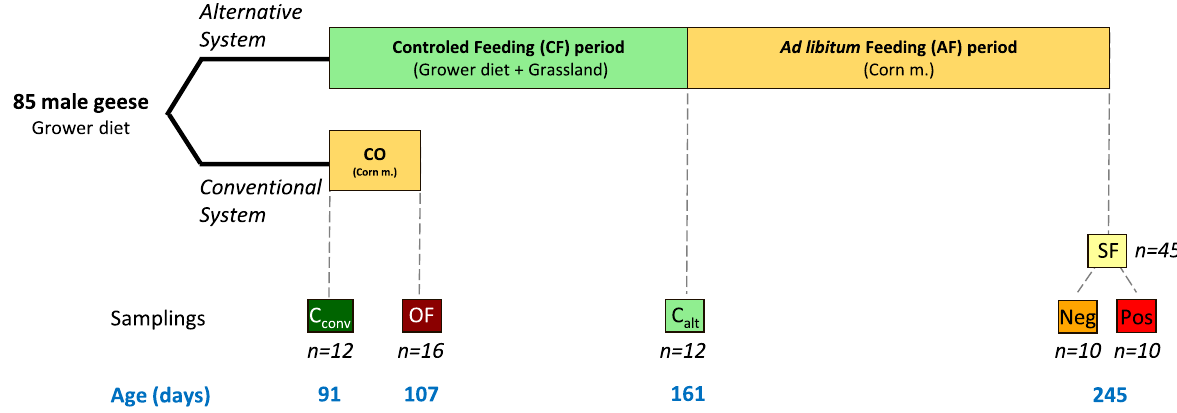
Fig. 1 Experimental design. Two steatosis induction rearing systems were studied, the conventional one using conventional overfeeding (CO) with a corn mixture (Corn m.) and an alternative one using a spontaneous steatosis stimulation alternating a controlled feeding (CF) period with a grower diet and an access to a grassland and an Ad libitum feeding (AF) period with the same corn mixture as in the conventional system. In both systems samplings were made before (C conv and C alt groups) and after corn mixture feeding (OF and SF groups). At the end of the AF period 45 geese were sampled and the 10 animals with the highest (PosSF) and the lowest (NegSF) liver weights were selected. AF: Ad libitum feeding, C: Control, CF: Controled Feeding, CO: Conventional overfeeding, OF: Overfeeding group, SF: Spontaneous fattening